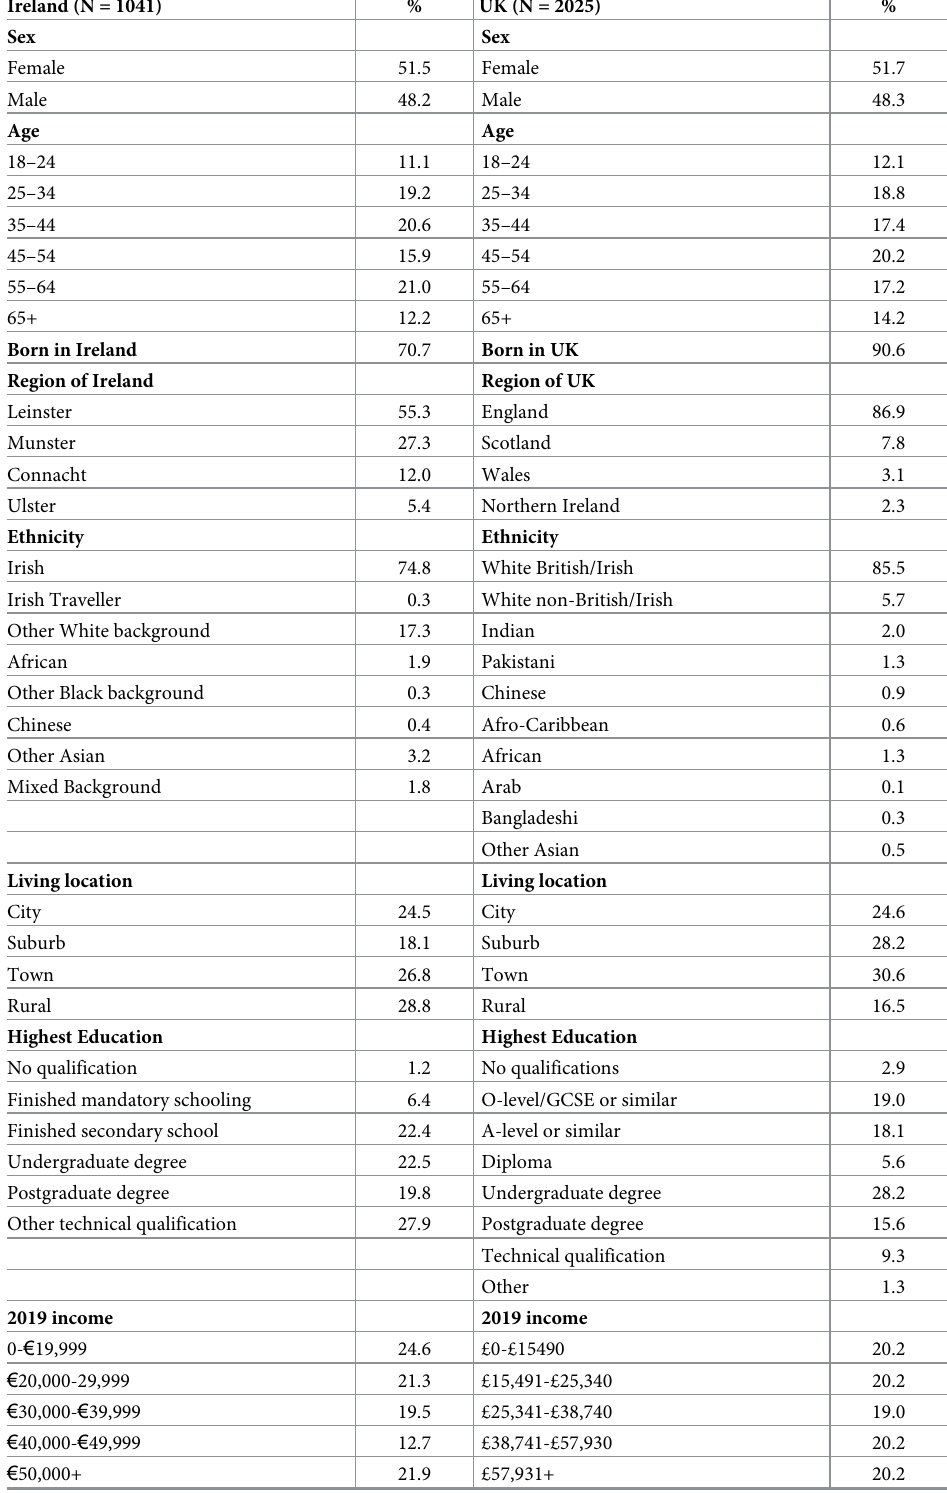
Table 1. Sociodemographic characteristics of the Irish and UK